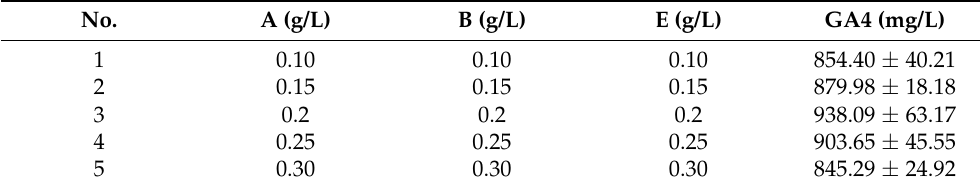
Table 8. The steepest ascent experiment design and results; the values represent the mean ± SD of three